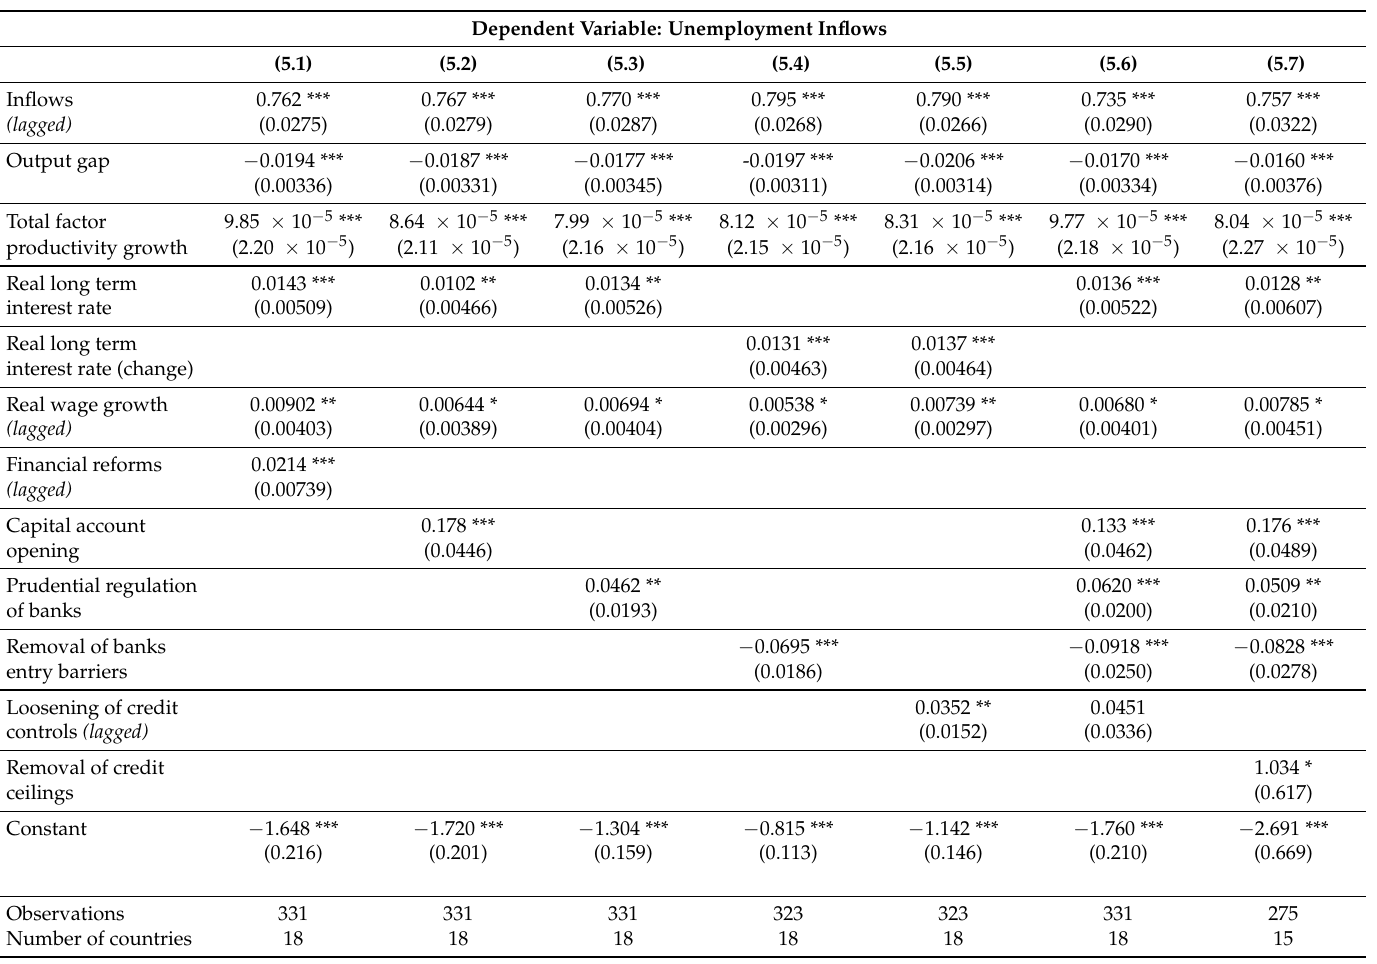
Table 5. Robustness check: financial market reforms and unemployment